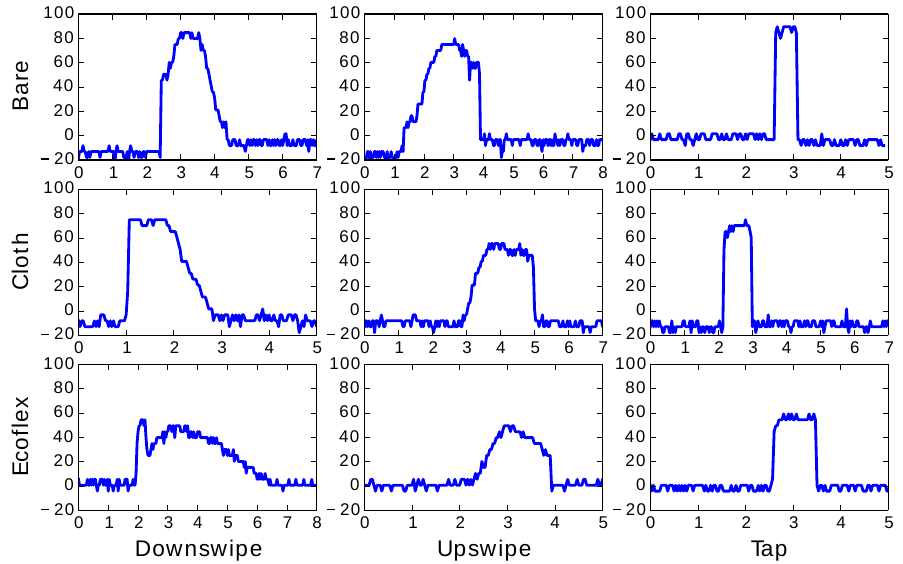
Figure 17. Characteristic gesture signals for down swiping, up swiping and tapping, for three configurations of the prototype. Horizontal axes are time (in seconds). Vertical axes are the measured voltage (in